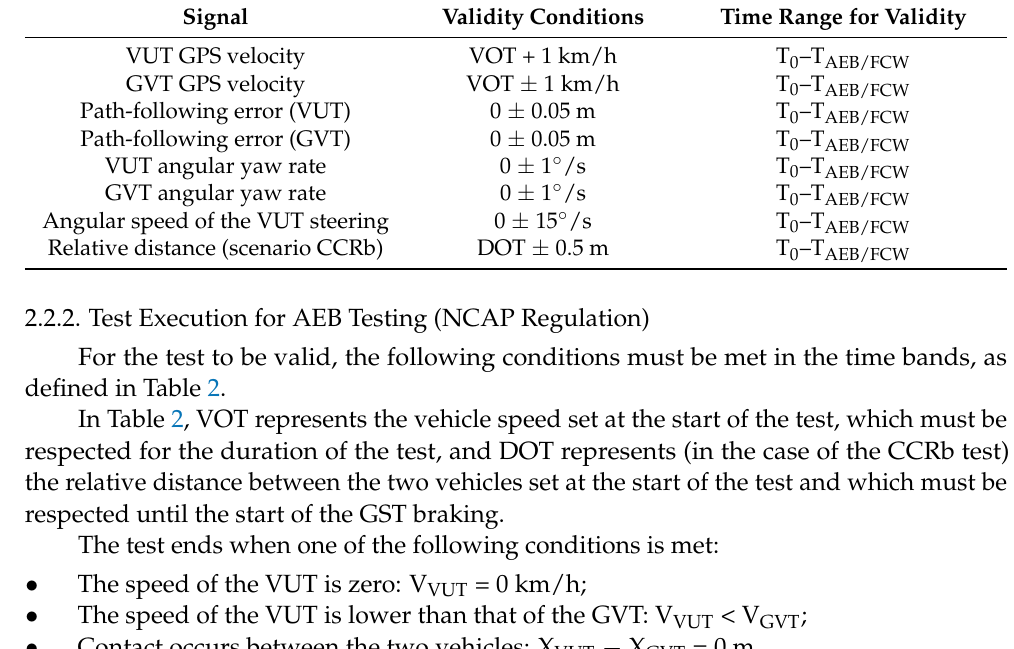
Table 2. Regulation limits for AEB testing according to NCAP regulation. Signal Validity